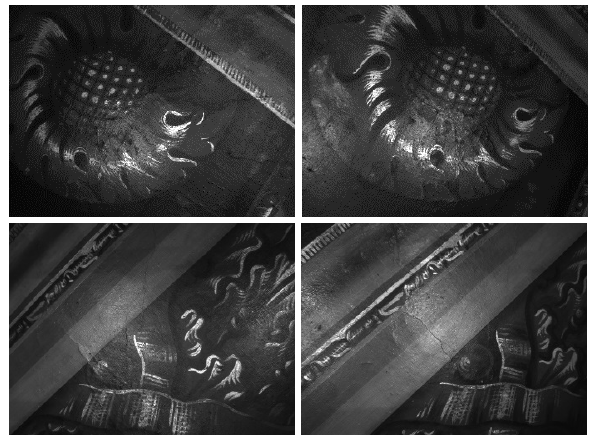
Figure 7. Pairs of images from left and right cameras under LED lighting at first location (top) showing a flake and second location (bottom), showing a crack.